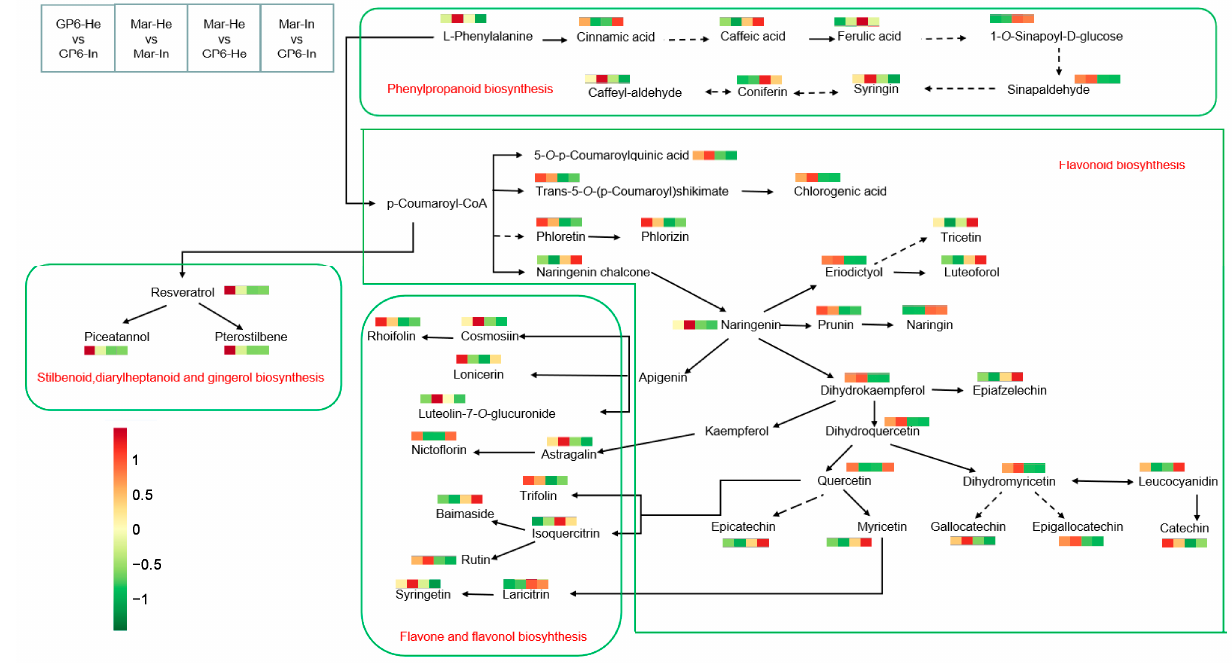
Figure 6. Pairwise comparisons of changes in key metabolites mapped to metabolic pathways in grape fruit. Heatmap colors represent the metabolites expression (log 2 fold change) for each com-